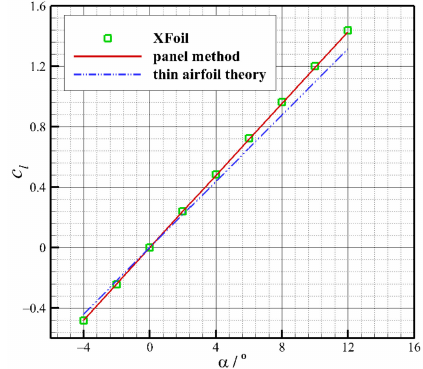
Figure 7. Comparisons of the lift coefficient in